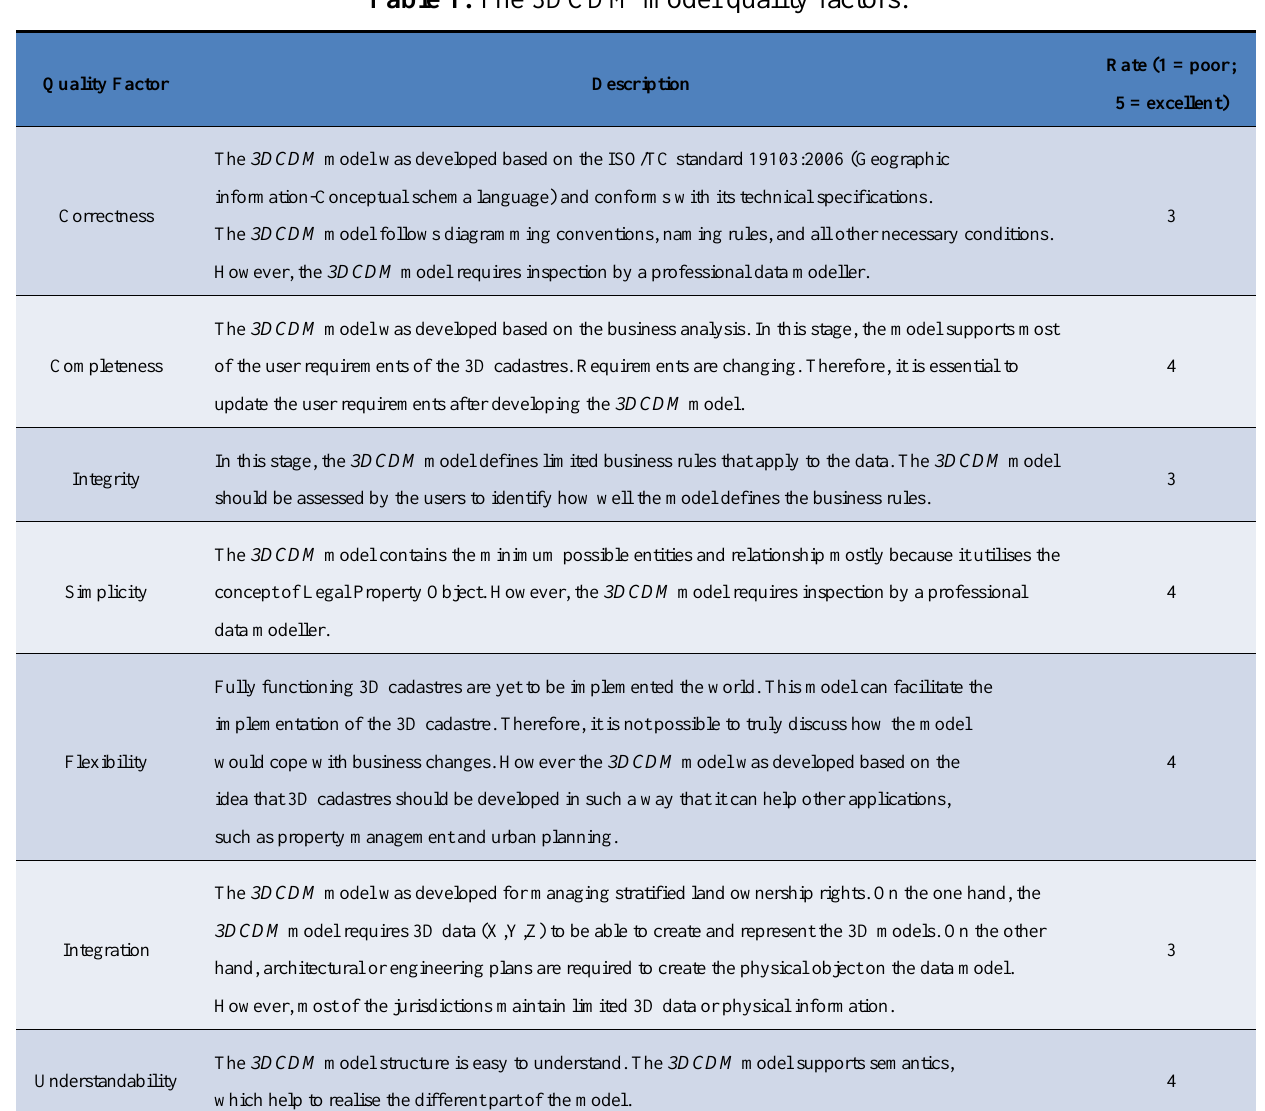
Table 1. The 3DCDM model quality